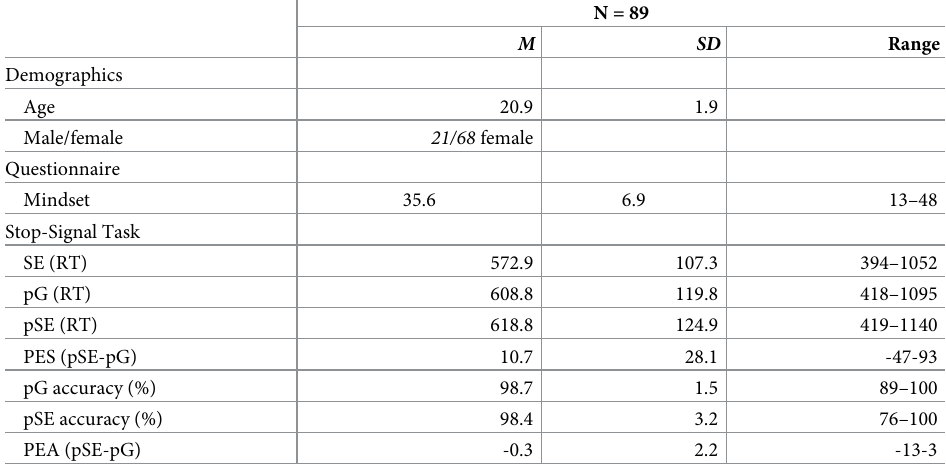
Table 1. Questionnaire and performance